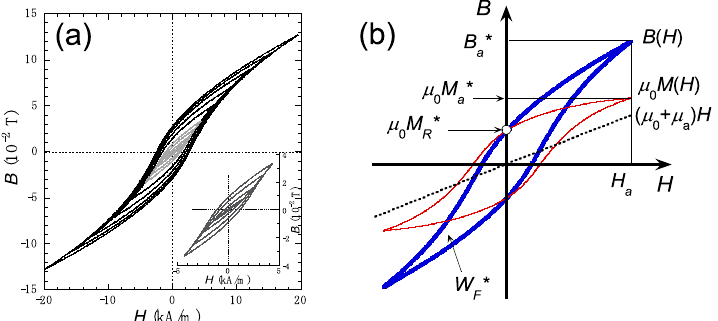
Figure 3. ( a ) A set of minor hysteresis loops. The data for 502 MPa are given as an example. Minor loops with H a below 4 kA/m (gray loops and the inset) were used to obtain minor-loop coefficient ( W m0 ). ( b ) Schematic diagram of the hysteresis loops and the parameters of the magnetic-flux-density B ( H ) loop (blue thick line). In addition to µ 0 M ( H ) (red thin line) due to ferromagnetic α′ -martensites, both µ a H and µ 0 H (dotted line) are involved in the B ( H ) loop. Here, M ( H ) is the magnetization, and µ 0